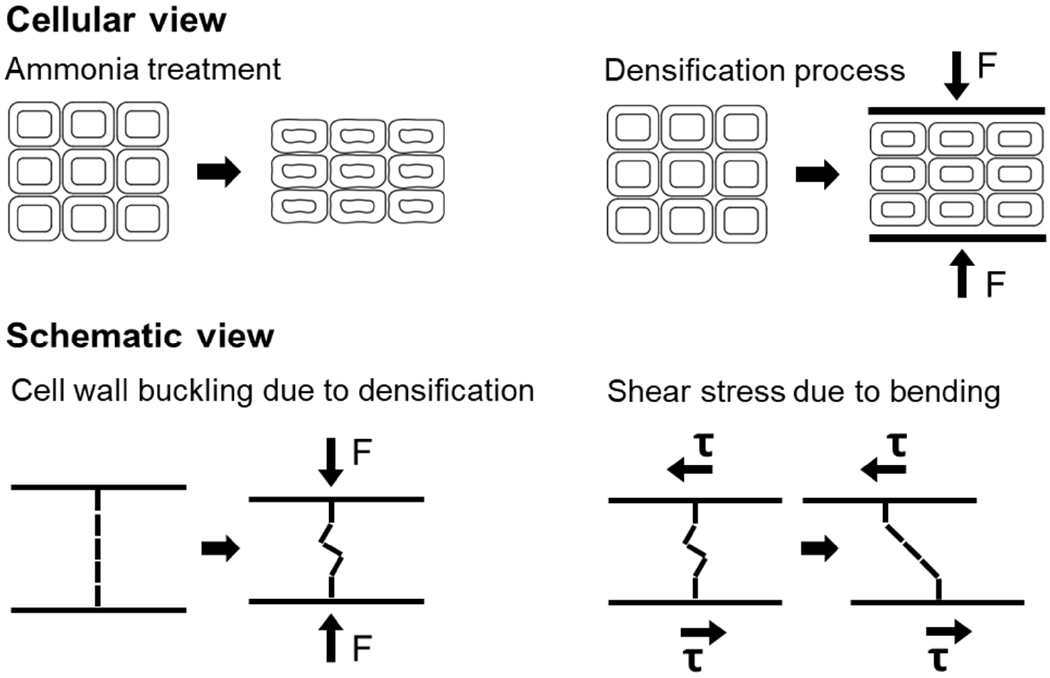
Figure 2. ( Top ): cellular view: both ammonia treatment and mechanical densification lead to cell wall buckling. ( Bottom ): schematic view: cell wall buckling leads to higher deflection during bending test.